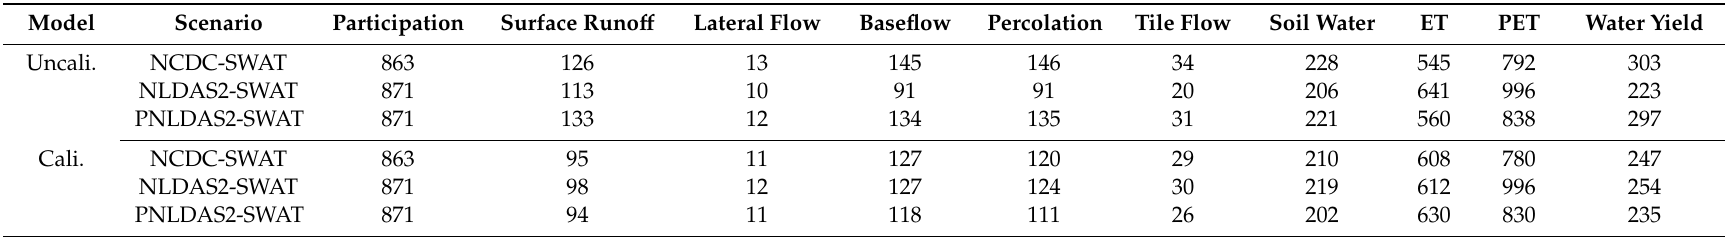
Table 6. Average annual water balance components (in mm) over the UMRB simulated using the uncalibrated and calibrated SWAT model in three scenarios. Model ET PET Water Yield Uncali.